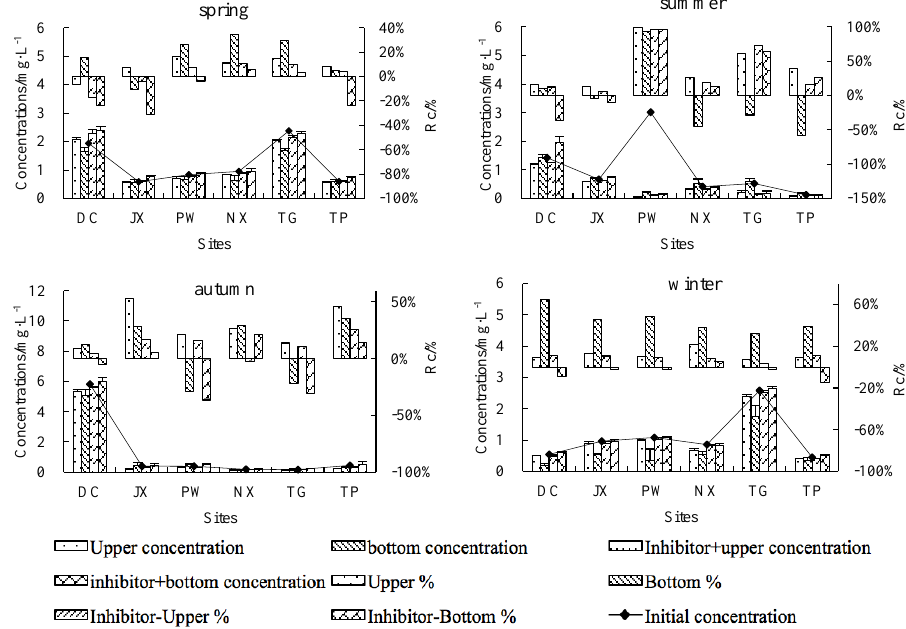
Figure 5. Initial NH 4 + -N concentrations (line), final upper- and bottom-layer NH 4 + -N concentrations (lower histogram) and percent change from initial NH 4 + -N concentration (upper histogram). A negative percentage indicates an increase in concentrations and vice versa.